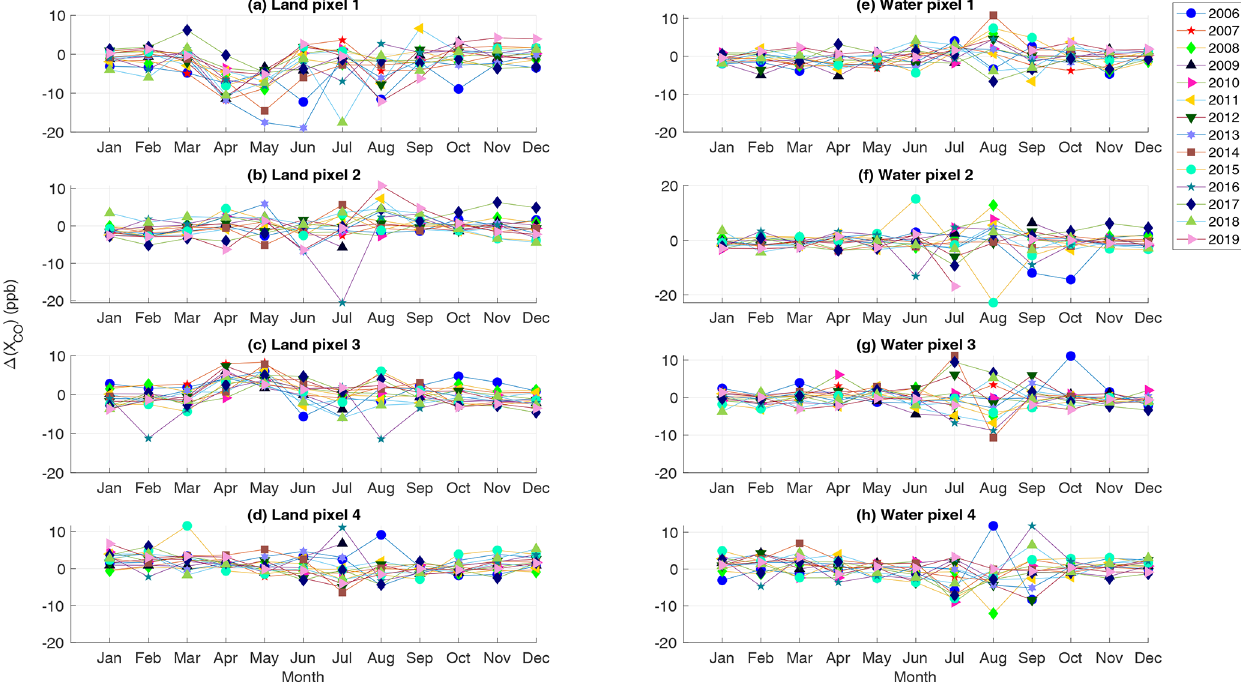
Figure 2. Monthly MOPITT pixel biases compared to the weighted means of all pixels over land and water over each year. Colors and symbols indicate each year from 2006 to